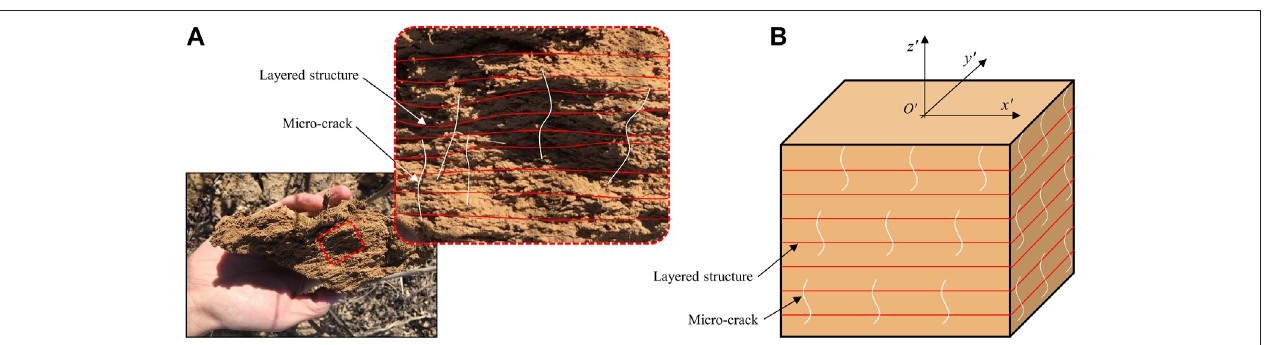
FIGURE 4 | Structural characteristics of the loess: (A) loess sampled at the study site and (B) generalised model of the structure of the loess.